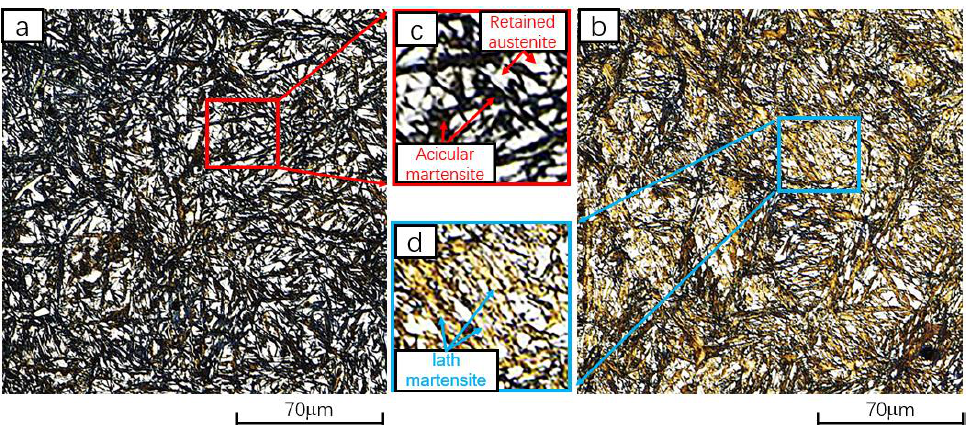
Figure 1. Optical micrographs from the surface to the heart of the Process 1 sample: ( a ) carburized surface layer; ( b ) transition layer; ( c ) black (acicular martensite); white (retained austenite); ( d ) yellow (lath martensite).